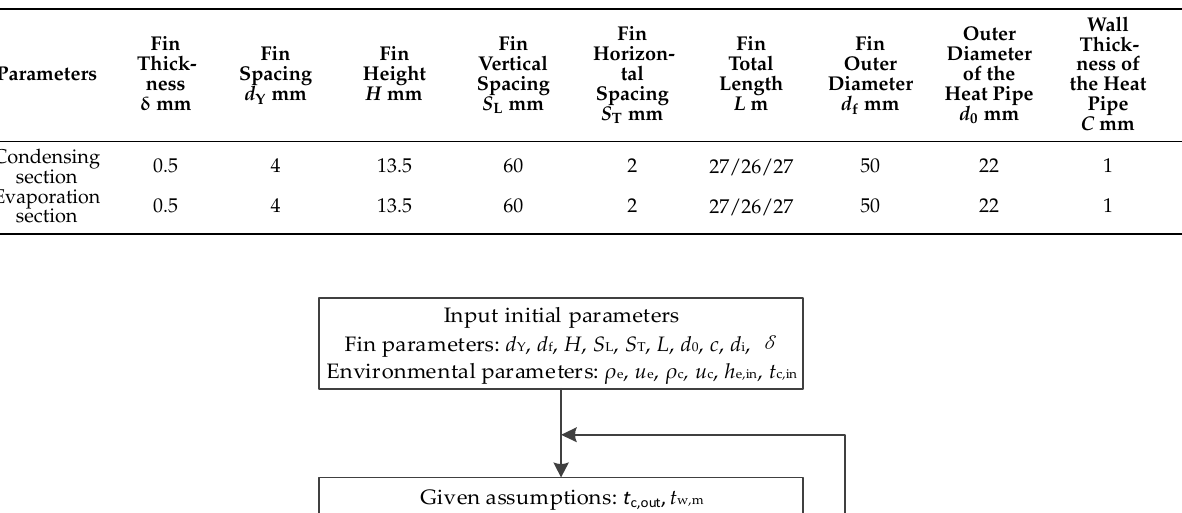
Table 5. Experimental parameters of heat pipe heat exchanger.